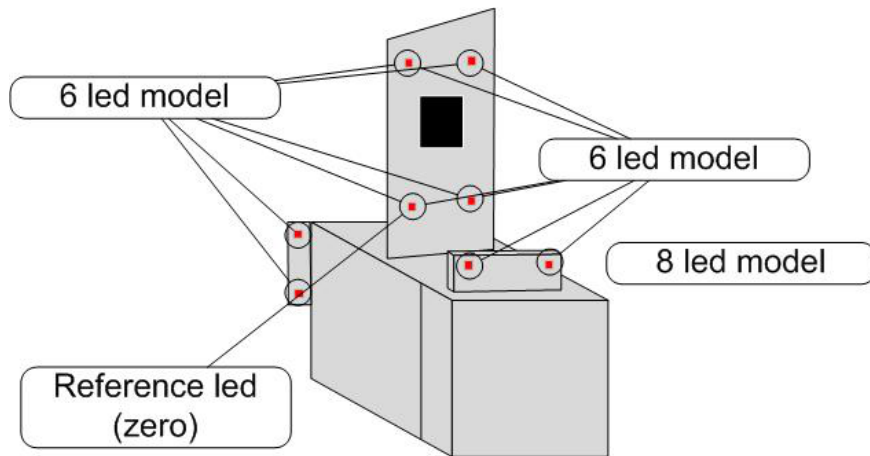
Figure 5. Detection algorithms using different